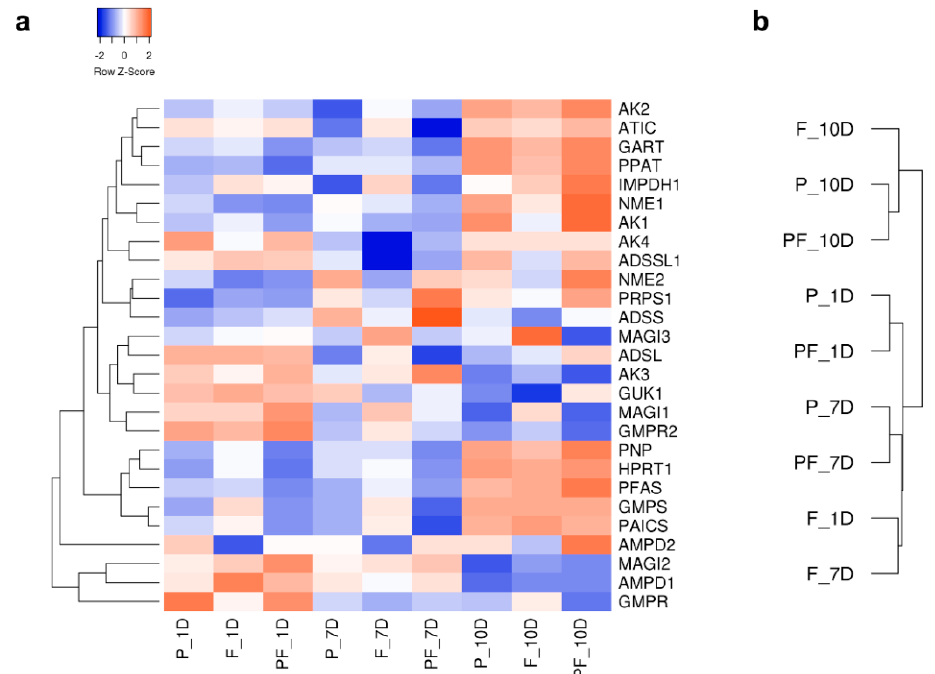
Figure 6. Differential regulation of selected genes after palbociclib (P), fulvestrant (F), and combination (PF) dosing, one day (1D), seven days (7D) and ten days (10D) post-dose: ( a ) heatmap of dysregulated genes (gene changes expressed as z-scores of the fold change), ( b ) cluster analysis of gene expression profiles. Table 3. Active pathways mapped using untargeted metabolite and RNA-seq data at seven days post combination dose by XMCS Online. Pathway names provided by BioCyc Database Collection [25].